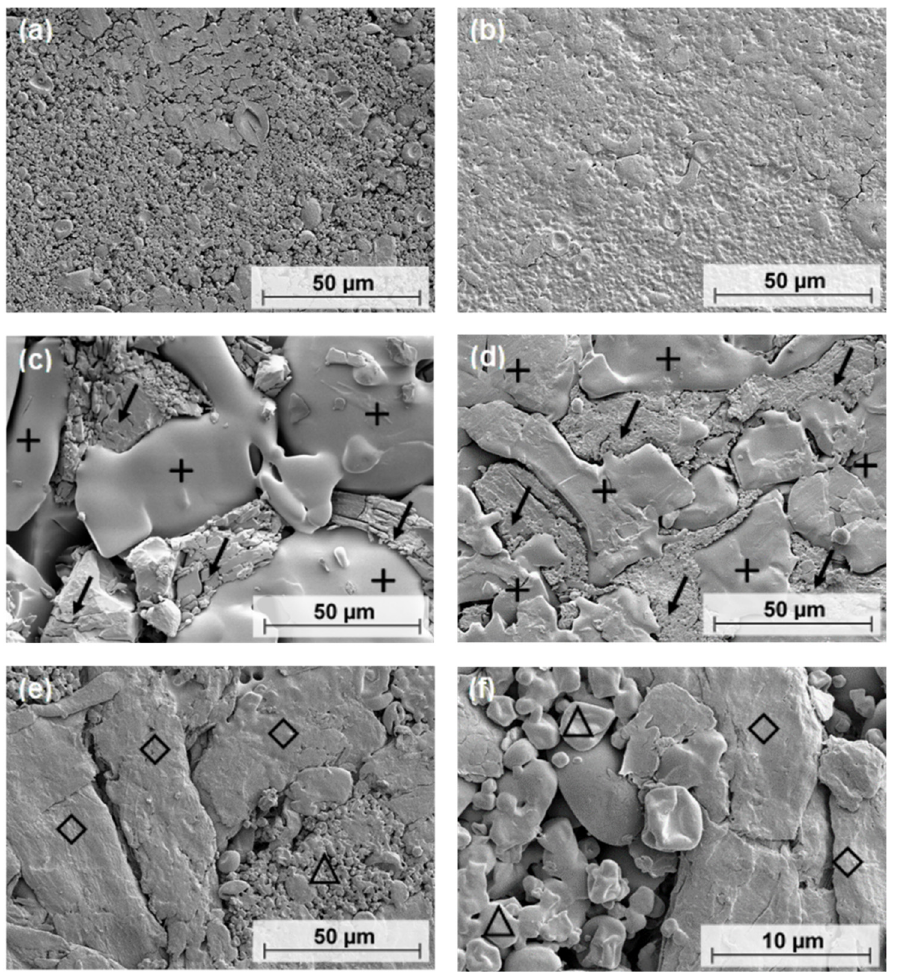
Figure 10. Scanning electron microscope (SEM) images of different tablets: ( a ) surface of pure ASD VA30 tablet, compressed at 5 kN; ( b ) surface of pure ASD VA30 tablet, compressed at 40 kN; ( c ) surface of pure PM VA30 tablet, compressed at 5 kN; arrows indicate PCM and crosses indicate PVP/VA; ( d ) surface of pure PM VA30 tablet, compressed at 40 kN; arrows indicate PCM and crosses indicate PVP/VA; ( e , f ) surface of ASD VA30 tablet with MCC 200, compressed at 10 kN; triangles indicate ASD VA30 and rhombuses indicate MCC 200.